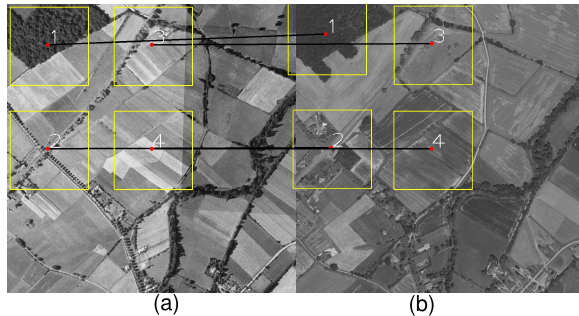
Figure 2. The output of the 2D patch matching procedure obtained for the dataset Fabas situated in France, with N = 4 homologous patches: (a) historical orthoimage I old (1962), (b) recent orthoimage I new (2010); patch ray size r = 140 pixels, encoding a surface area of 252 . 9 m 2 per